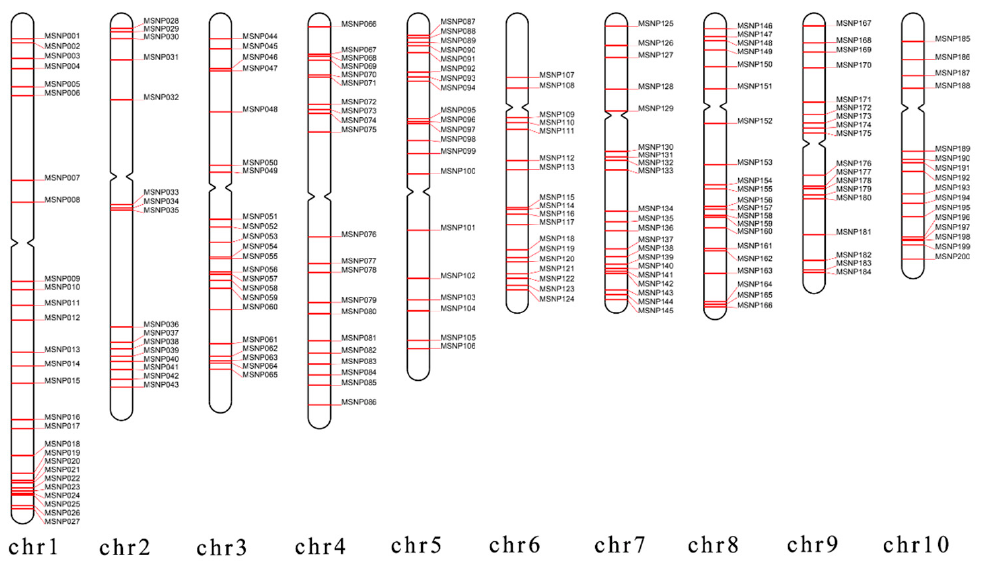
Figure 2. Distribution of 200 SNPs on 10 chromosomes of maize genome.